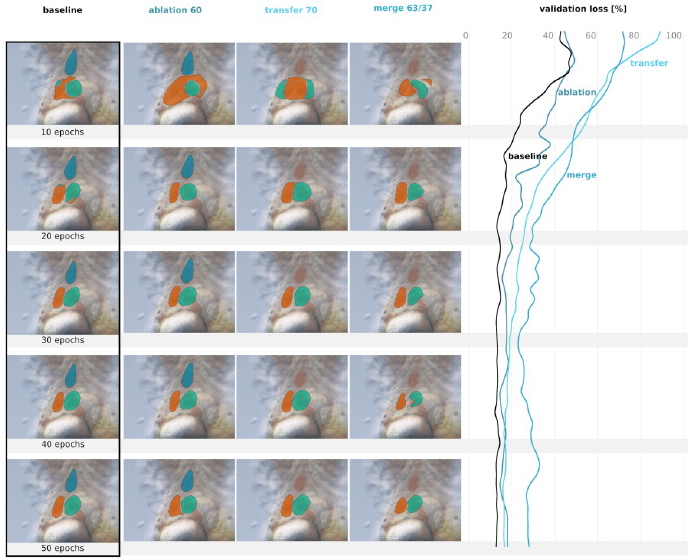
Fig 4. Predictions of different training schemes. For reasons of comparability, the predictions are shown for the same sample (see Fig 2). The first column presents the development of the baseline model’s prediction during the training, followed by the ablation experiment with 60% dropped labels, the transfer learning approach with 70% dropped labels, and the merge experiment with a ratio of 63% to 37%. The rows depict the predictions’ state after e training epochs (10, 20, 30, 40, 50). For detailed results of the experiments, see Section 3. The last column shows the validation loss development during training, presented as a moving average with kernel size three.